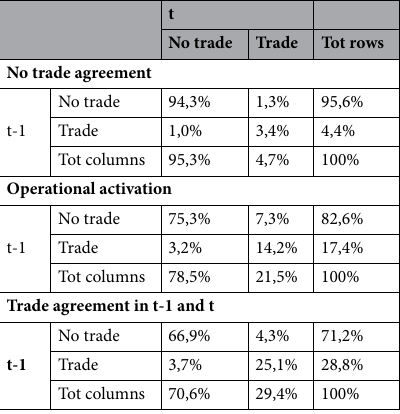
Table 1. Contingency tables. Each table refers to one of the three cases described in the “Methods”